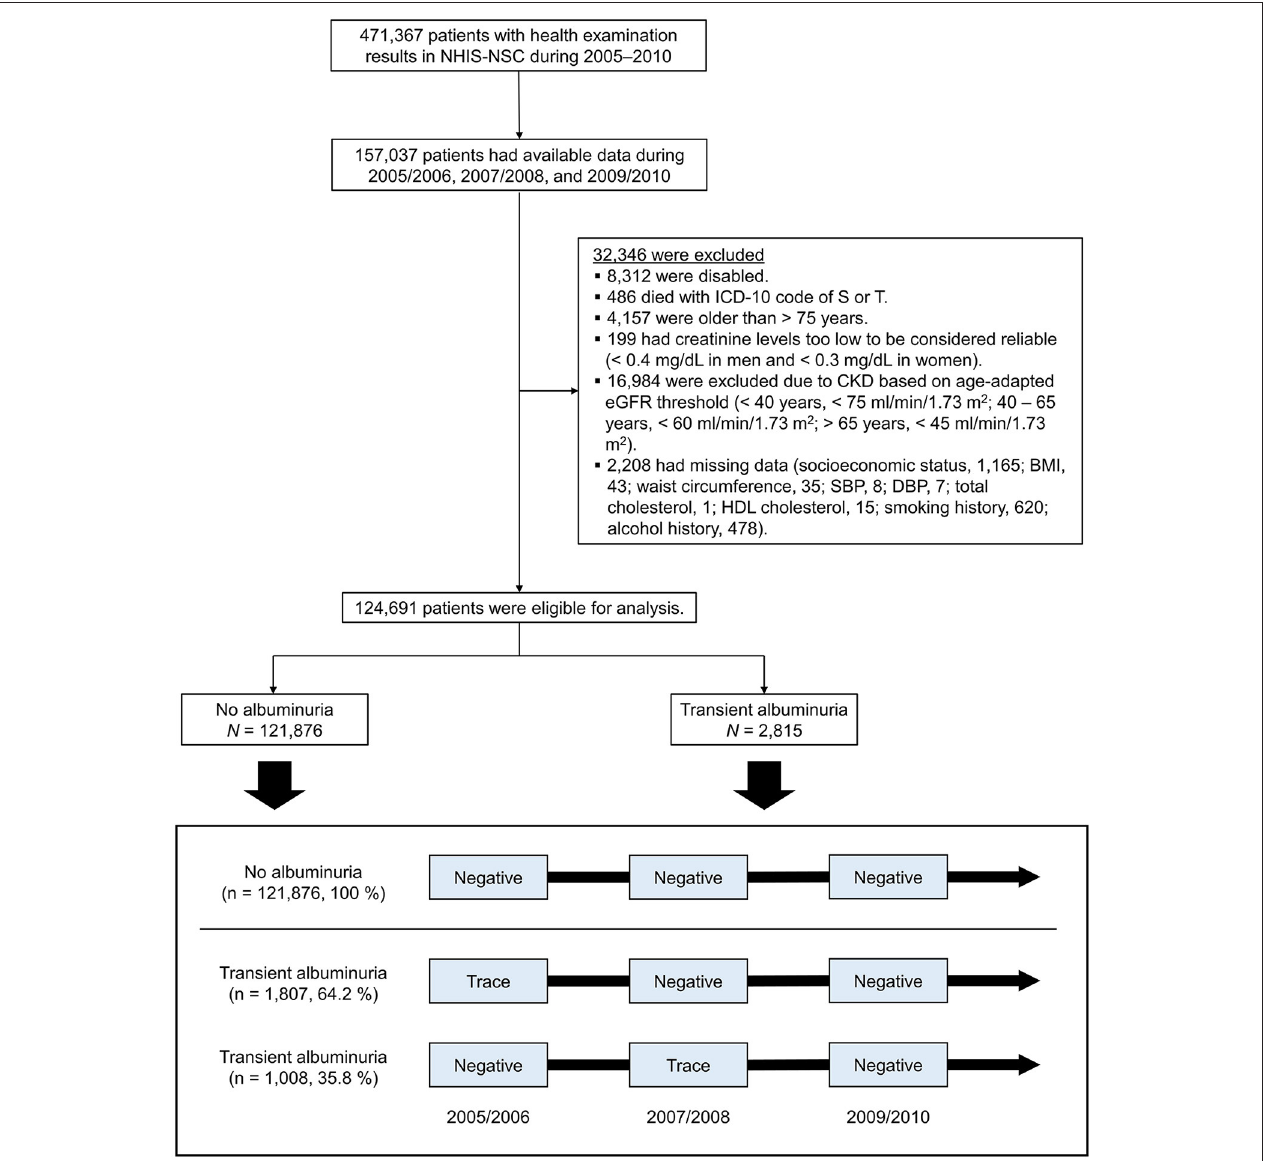
FIGURE 1 | Flow chart depicting a diagram of patient enrollment. The box shows how the observation period was structured. NHIS-NSC, National Health Insurance Service-National Sample Cohort; ICD-10, International Classification of Diseases, 10th revision; CKD, chronic kidney disease; eGFR, estimated glomerular filtration rate; BMI, body mass index; SBP, systolic blood pressure; DBP, diastolic blood pressure; HDL, high-density